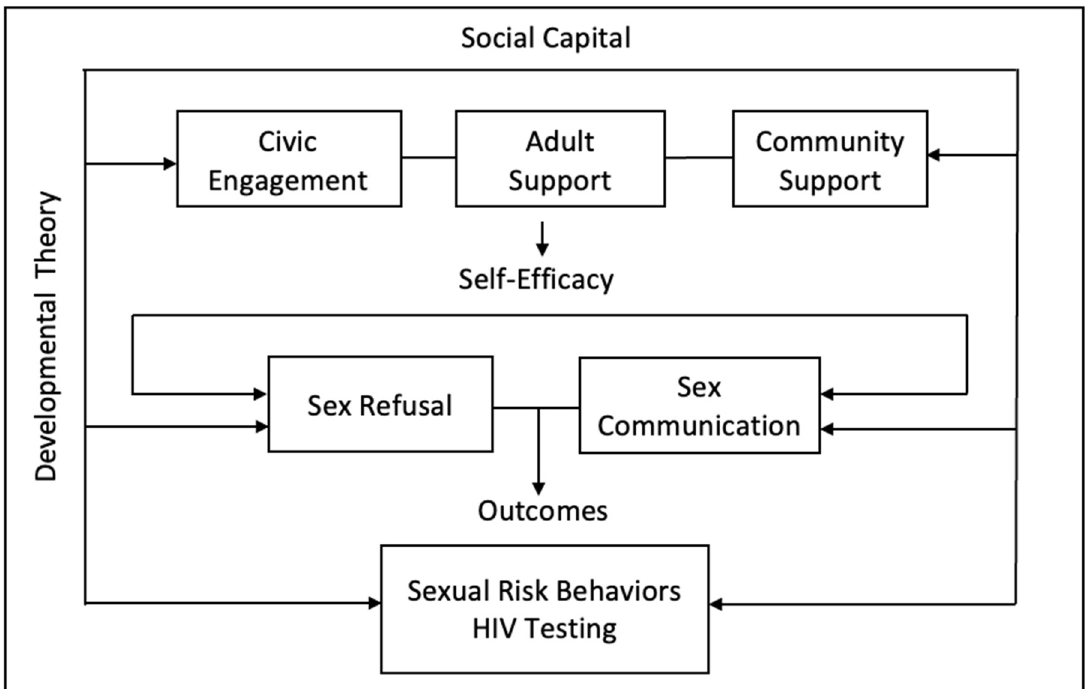
Figure 1. Conceptual framework guiding the present study.